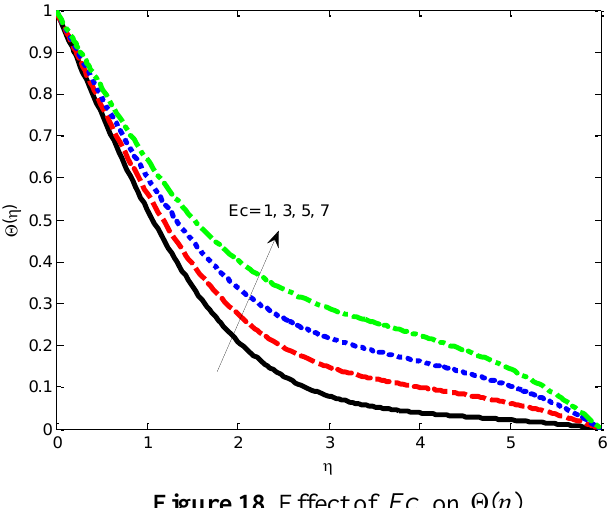
Figure 18. Effect of Ec on ( ) 